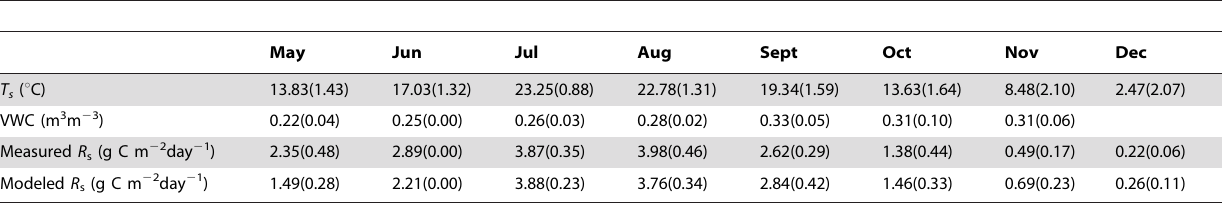
Table 2. Comparison of measured mean soil respiration and corresponding modeled mean derived from the days with no occurrence of missing hourly value over 24-hour time period, and corresponding soil temperature ( T s ) and soil moisture (VWC) in 2008.